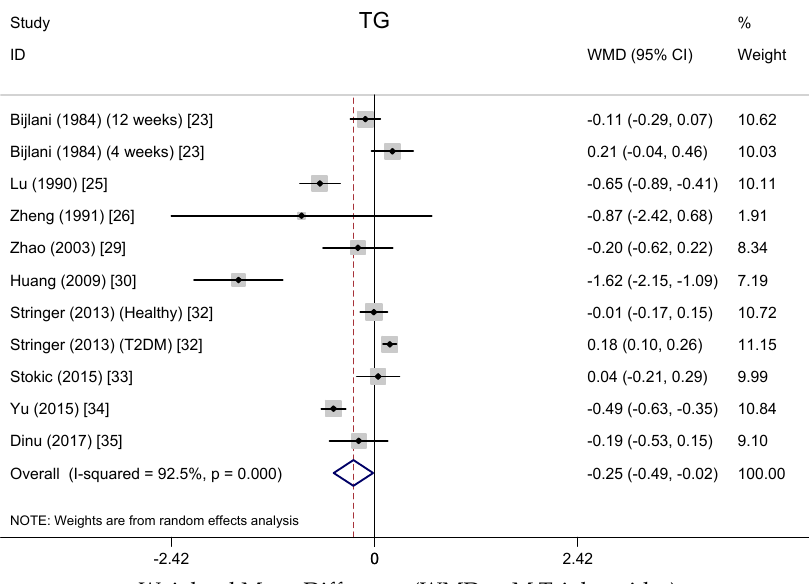
Figure 5. Meta-analysis of the effects of buckwheat products intake on blood HDL cholesterol concentration compared with baseline or control groups for human studies. Sizes of data markers indicate the weight of each study in the analysis. WMD, weighted mean difference (the results were gained from a random-effects model). Negative values favor a reduction in blood HDL Cholesterol with buckwheat consumption; the dashed line shows the overall WMD value and the size of the rhombus the cumulative effect size and CI.